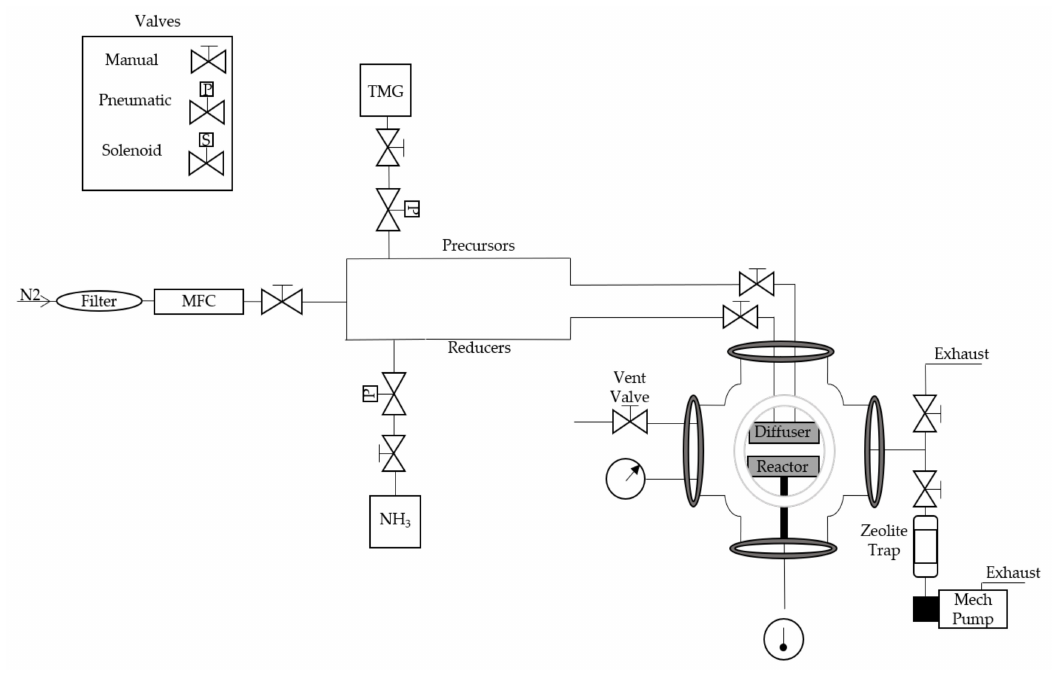
Figure 1. A schematic of the high-temperature atomic layer deposition (ALD) gas handling system, the vacuum chamber and vacuum pumping